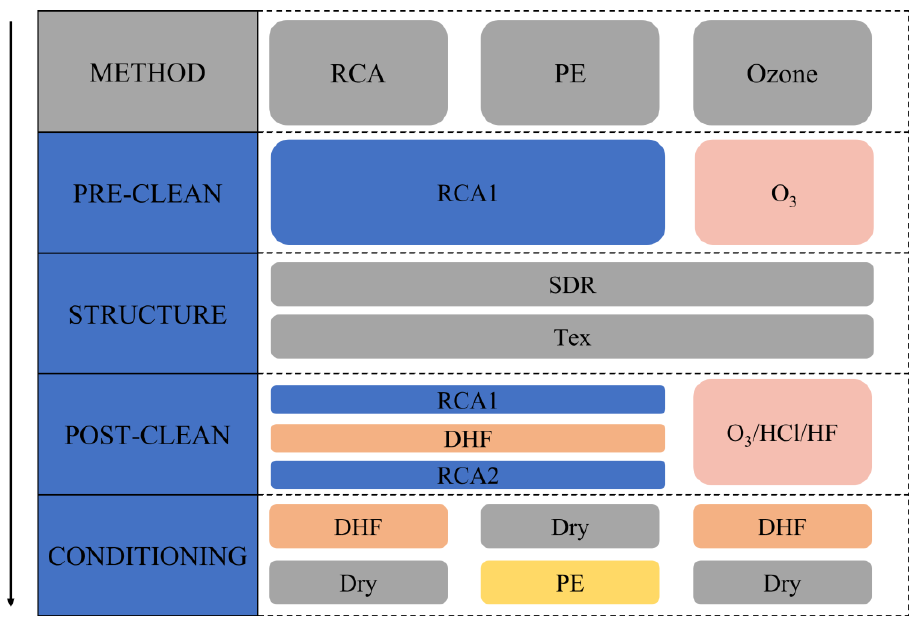
Figure 3. Comparison of three surface cleaning techniques for specific chemicals and processes. For a better understanding, all cleaning steps before deposition are shown. The direction of the arrow on the left indicates the cleaning sequence. The abbreviations of SDR and Tex denote saw damage removal and texturing. Plasma etching (PE) is a dry etching method to remove silicon oxide layer.